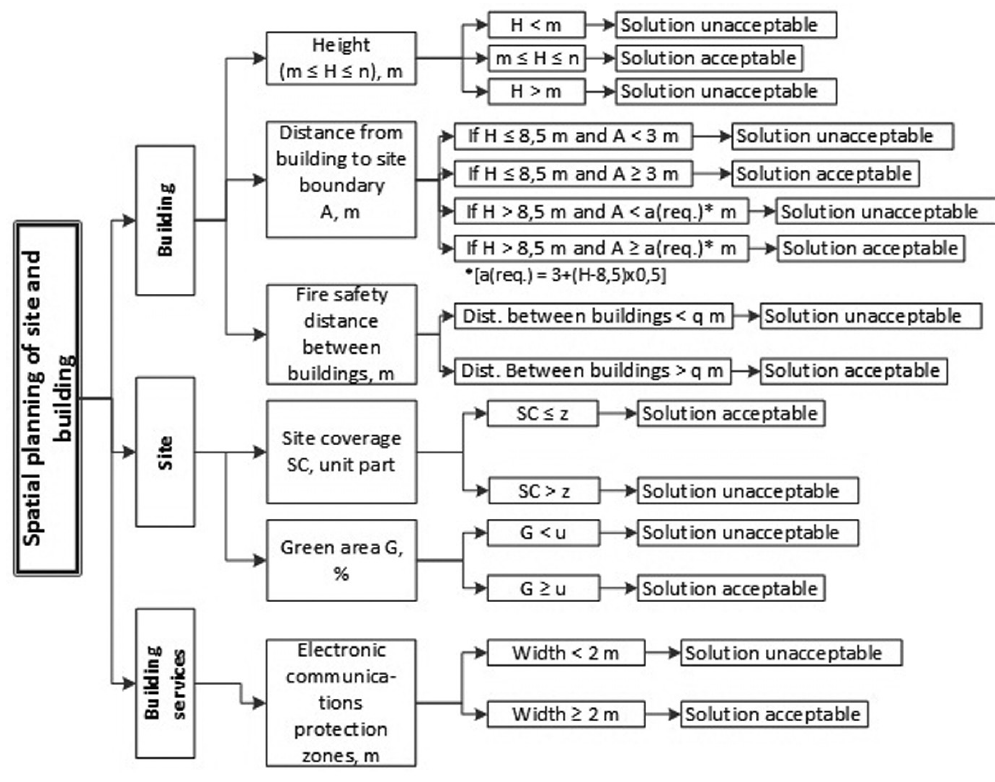
Fig. 5. Diagram of solutions tested in